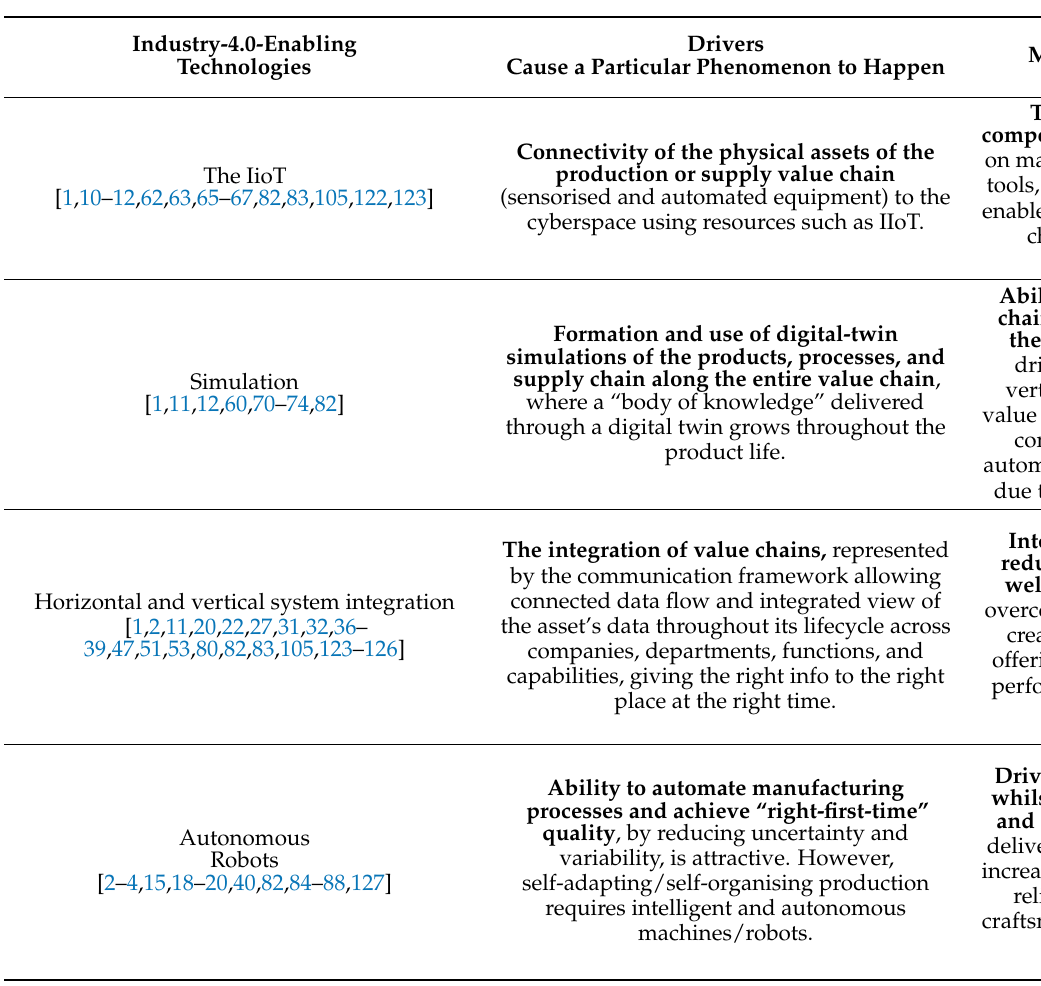
Table 1. Consideration of enabling technologies in the composite-manufacturing